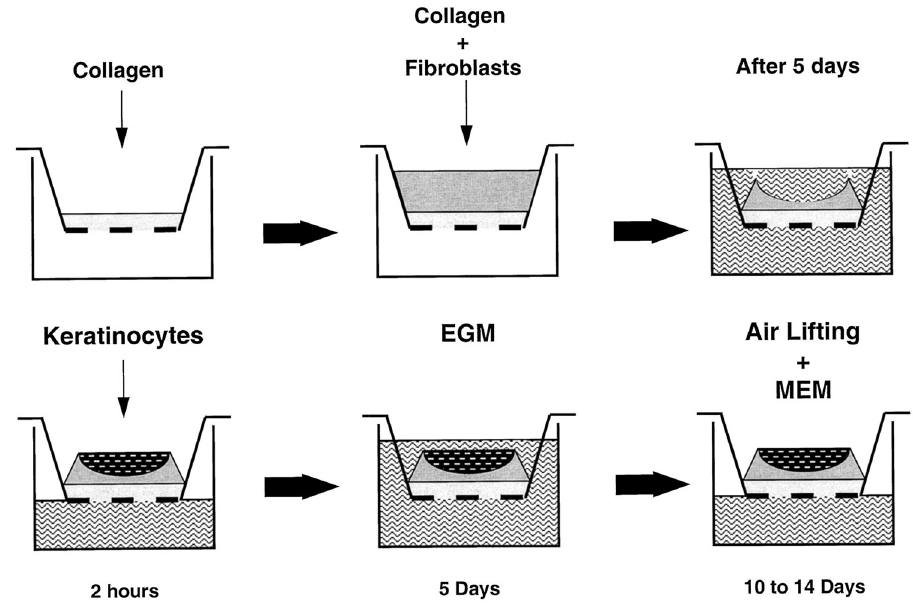
Figure 2: The overview of transwell/Boyden chamber approach protocol. The protocol of the organotypic human skin culture approach is similar to it. The main di ff erences are the cell types and medium for each experiment. Reproduced with permission from Meier et al. [ 19 ]